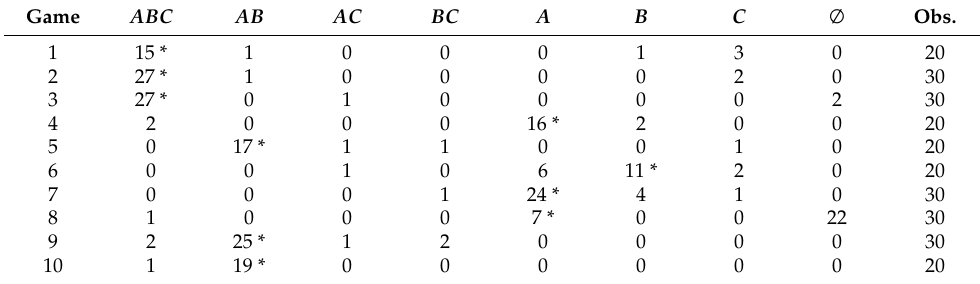
Table 3. Coalition formation in SEQ, * corresponds to the SPNE